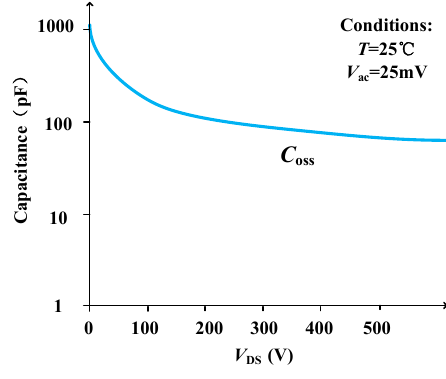
Figure 7. Curves of C oss and V DS .